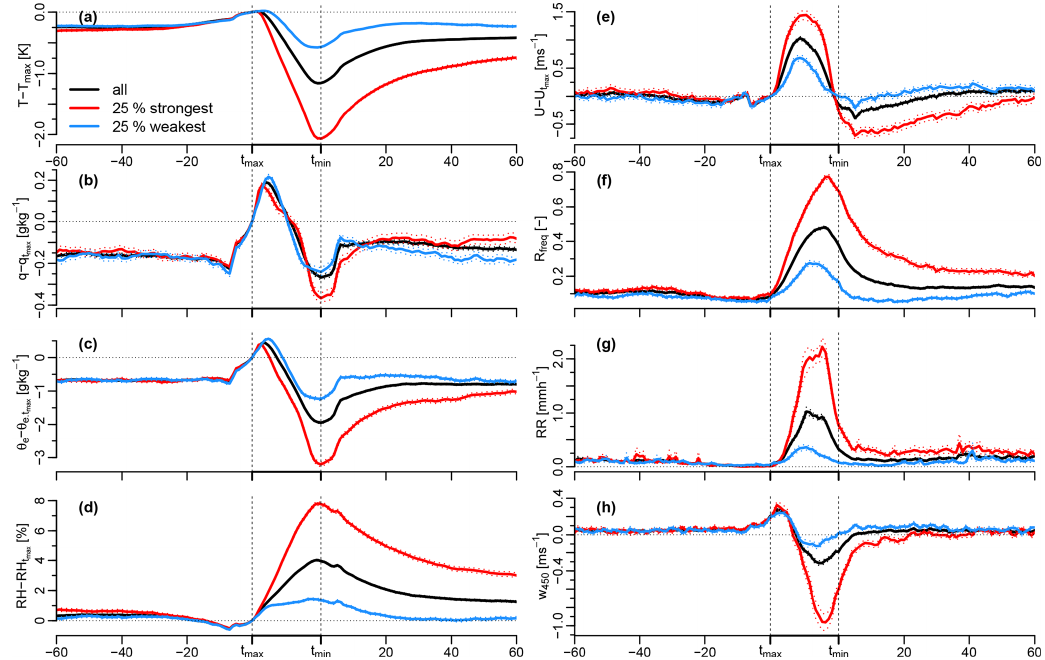
Figure 3. Composite mean temporal structure of anomalies with respect to the cold-pool onset ( t max ) for the surface properties (a) tempera- ture, (b) specific humidity, (c) equivalent potential temperature, (d) relative humidity, and (e) wind speed as well as absolute values of (f) the MRR rain frequency and (g) rain rate and (h) the vertical velocity at 450m height. The black line shows the mean structure of all cold pools matching the noprevWI criterion, and the red and blue lines show the mean for the 25% strongest and weakest cold pools, respectively. The dotted lines show the mean ± 1SE. Vertical and horizontal reference lines are added to indicate t max , t min , and